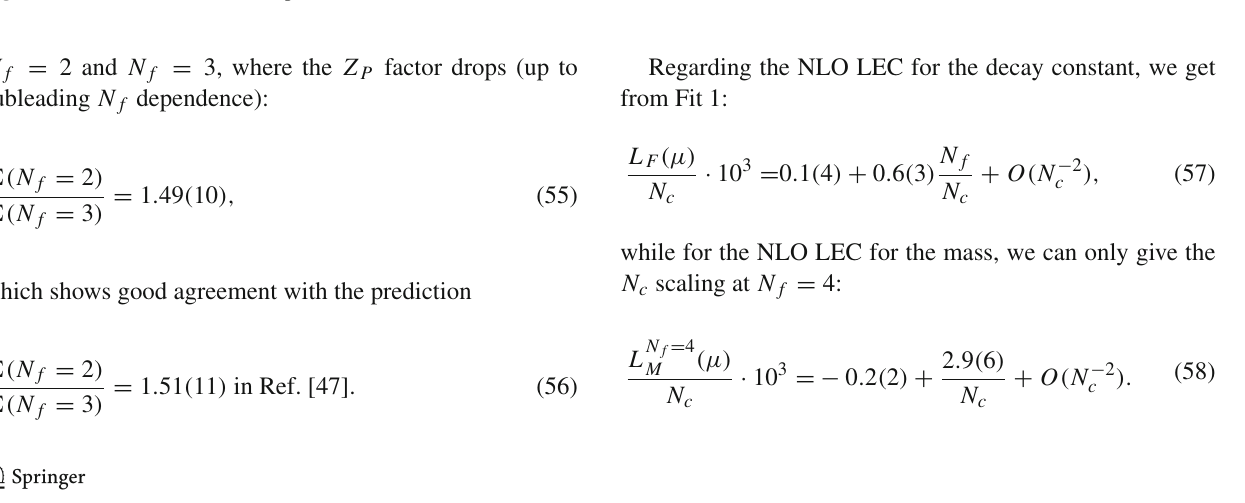
Fig. 5 Correlations between fitted parameters